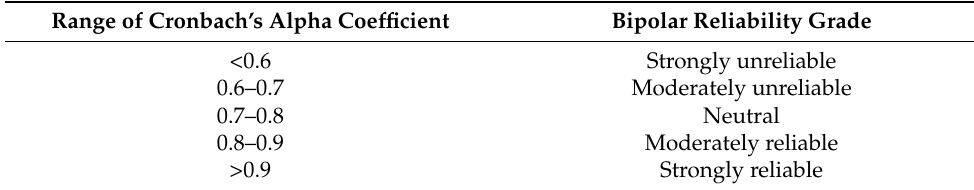
Table 5. Cronbach’s alpha coefficient and bipolar reliability grading criteria.